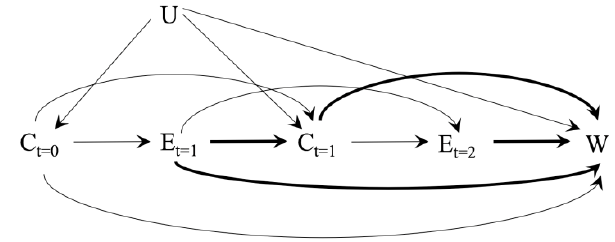
Figure 1 : Theoretical causal relations between maternal employment, children’s overweight, and